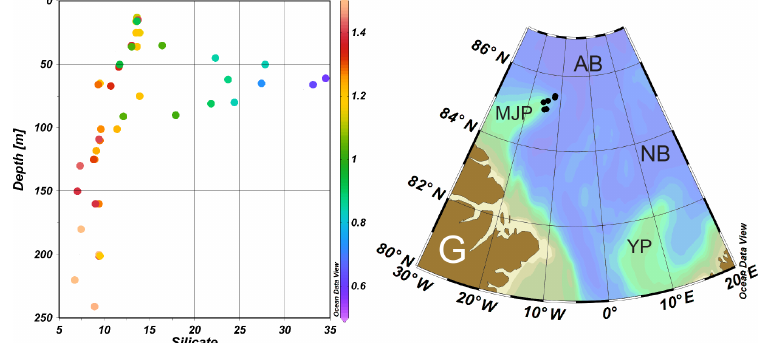
Figure 5. Silicate profiles of six stations over the Morris Jesup Plateau (MJP), colour-coded by (cid:127) aragonite , as observed during the Oden 91 cruise. Station positions are noted on the map, with the abbreviations being AB, Amundsen Basin; NB, Nansen Basin; YP, Yermak Plateau; and G,